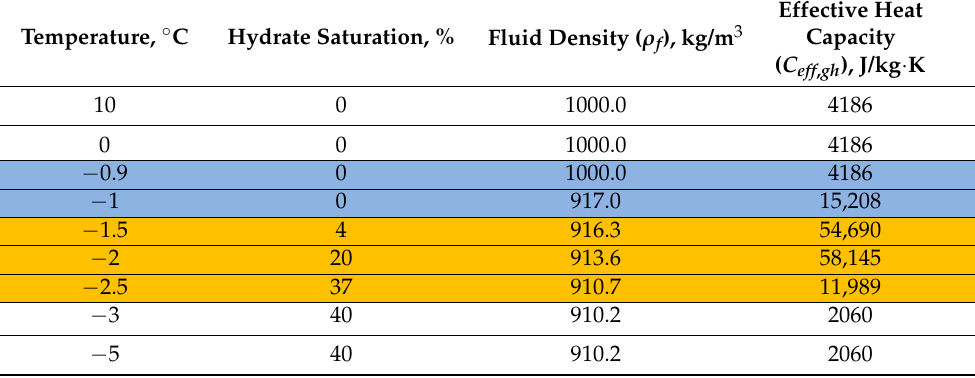
Table 6. Thermal properties of lean clay containing 40% of pore gas hydrates (depth interval 60–120 m), with regard to the phase state of pore moisture and temperature.